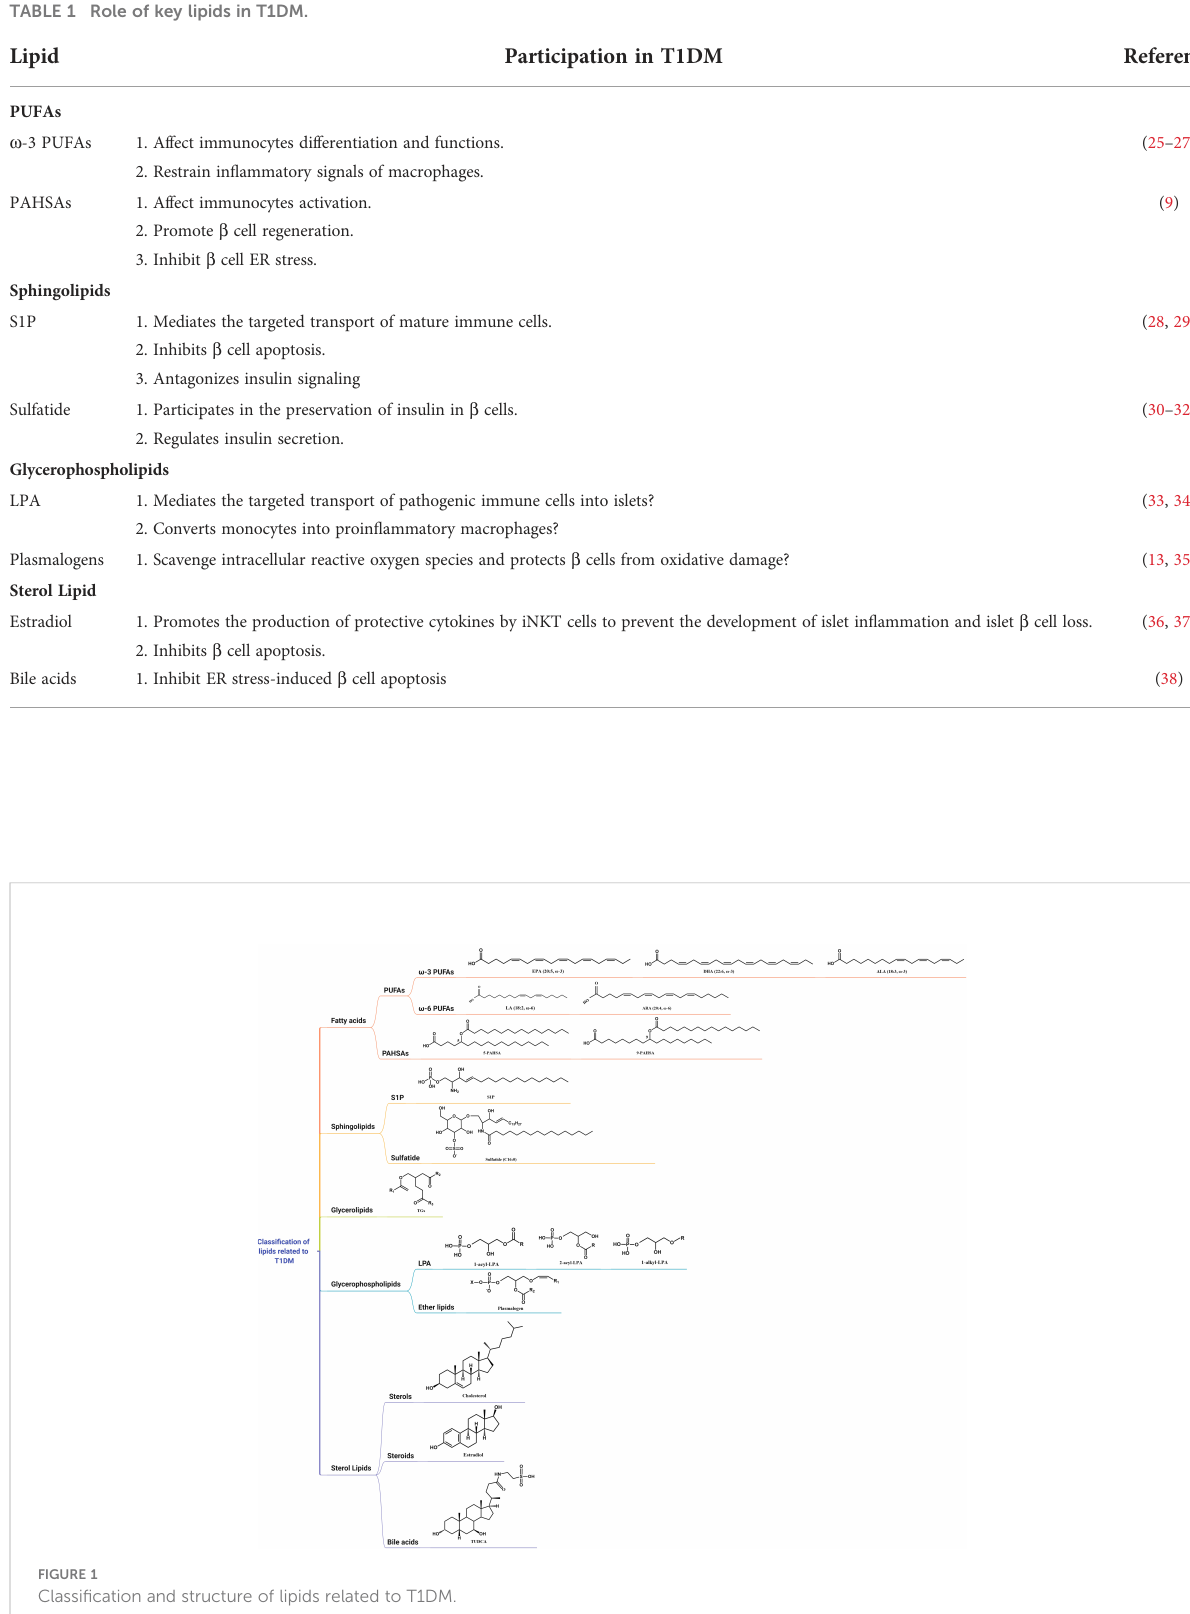
TABLE 1 Role of key lipids in T1DM.